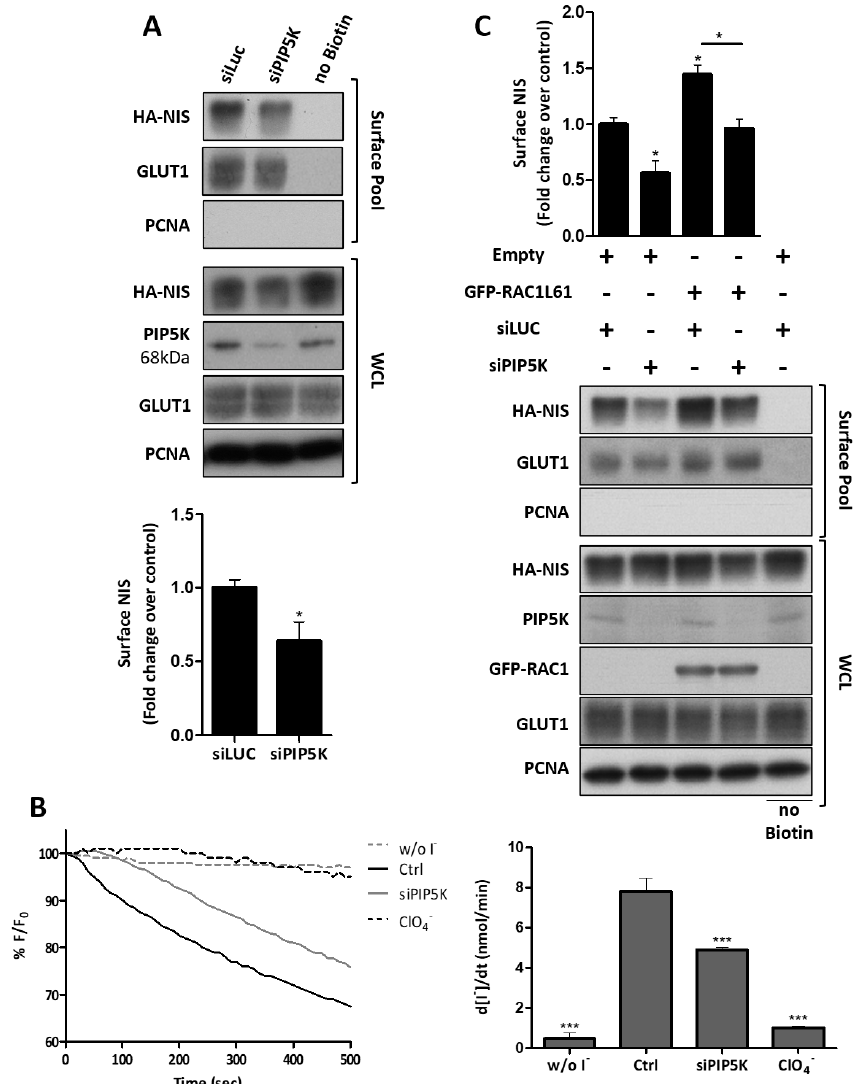
Figure 8. RAC1 signaling through PIP5K is required for NIS PM residency. HA-NIS-TPC1 cells were ( A ) transfected with either mock (siLUC control) or a specific siRNA against PIP5K (siPIP5K), and were analyzed by surface protein biotinylation. The surface fractions and whole-cell lysates (WCL) were then analyzed by WB, as indicated. The ‘no Biotin’ condition, corresponding to cells which were not incubated with biotin, was used to control the specificity of the biotinylated protein pull-downs. PCNA expression served as both the loading (WCL) and intracellular protein contamination control (Surface pool). GLUT-1 served as the positive loading control for cell-surface protein extracts. The WB bands were quantified by densitometric analysis using ImageJ software. The plotted values correspond to the means ± SEM of at least three independent assays. Significant variations were assessed by Student’s T test (* p ≤ 0.05). ( B ) Representative traces of the iodide-induced YFP fluorescence decay of HA-NIS/HS-YFP-TPC1 cells treated as in (A), or treated with or 50 mM of ClO 4 − for 10 min, which were continuously recorded for 500 s after exposure to 50 mM iodide (upper graph). The iodide influx rates (lower graph) were calculated by fitting the curves to the exponential decay function. The data are means ± SEM of five independent assays. Significant variations between the treatments were assessed by one-way ANOVA (F = 120.8; p < 0.001) followed by Dunnett’s post- hoc test, as compared with the control conditions (Ctrl) (*** p ≤ 0.001). ( C ) HA-NIS-TPC1 cells transfected with either empty vector (Empty) or GFP-RAC1-L61, and either mock (siLUC control) or the siPIP5K, as indicated, were analyzed by cell surface protein biotinylation followed by WB, as in ( A ). The plotted values correspond to the means ± SEM of at least three independent assays. One-way ANOVA analysis detected significant differences between the treatments (F = 18.49; p < 0.001). Post-hoc Tukey’s tests were used to identify significant variations relative to the control conditions or among the different treatments (the latter are indicated by horizontal lines) (* p ≤